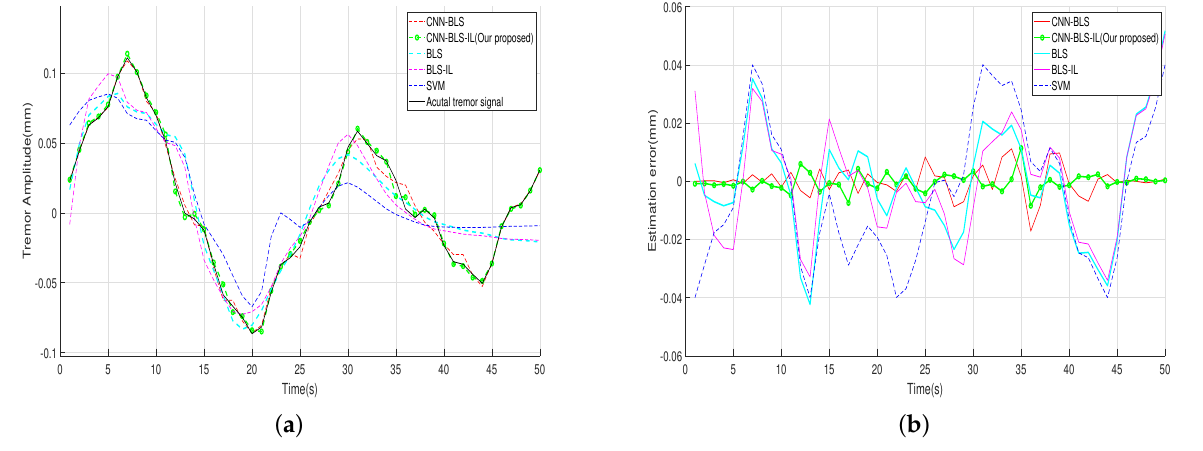
Figure 12. The simulated result metrics of different algorithms. ( a ) Tremor prediction by different algorithms in the case of tremors with small amplitude and high − low frequency. ( b ) Estimation error of different algorithms in the case of tremors with small amplitude and high − low